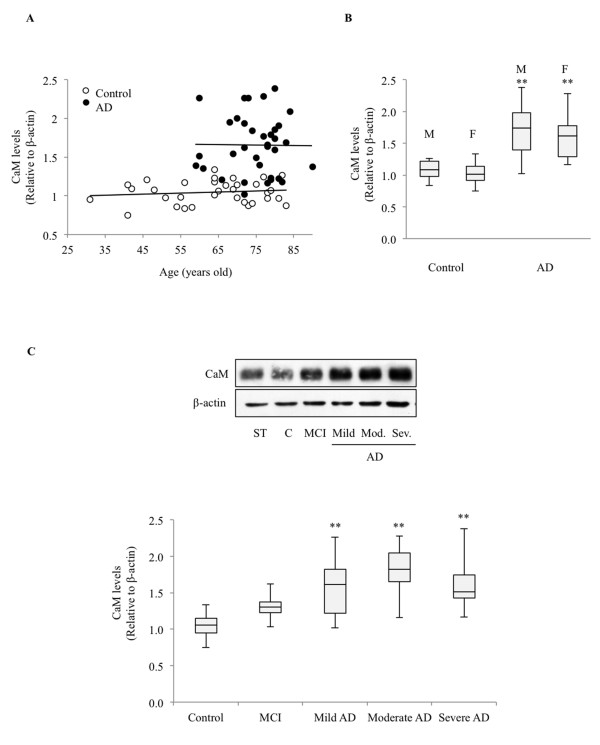
Influence of age, gender and disease severity on calmodulin levels. (A) Scatter plot of calmodulin (CaM) levels versus age in Alzheimer’s disease (AD) patients and controls. Correlation lines related to control and AD distributions are indicated. (B) Box plot of CaM levels in male (M) and female (F) controls and AD patients. (**p <0.0001, significantly different from both male and female controls). (C) Box plot of CaM levels of control, mild cognitive impairment (MCI) patients and AD patients classified within severity segments, as described in the upper part of Table 1. (**p < 0.0001, significantly different from control).